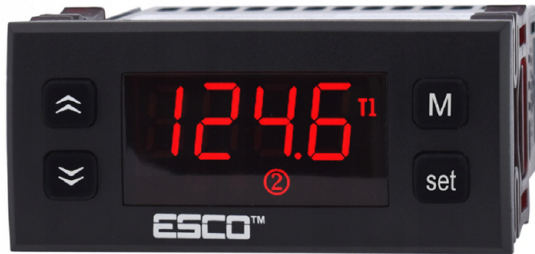
Figure 2. ESCO PT-20+